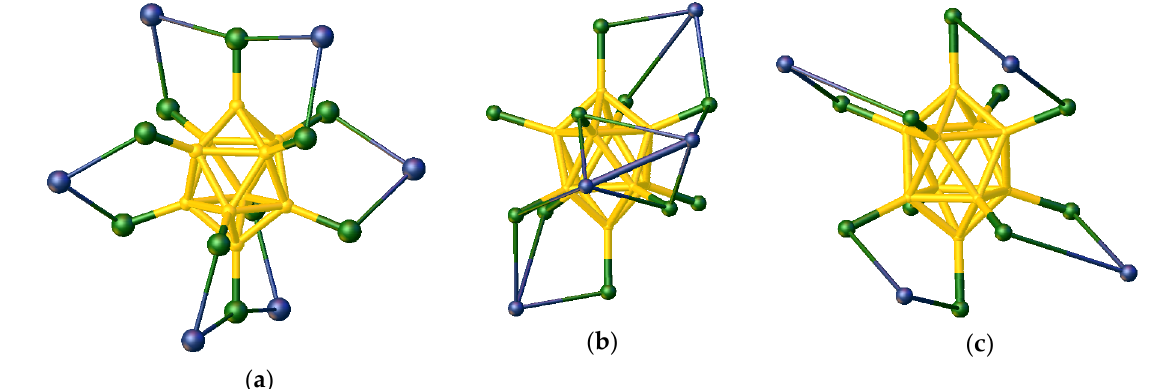
2 − in (a) 6 , ( b ) 7 , and ( c ) 8 10 Cl 10 ]